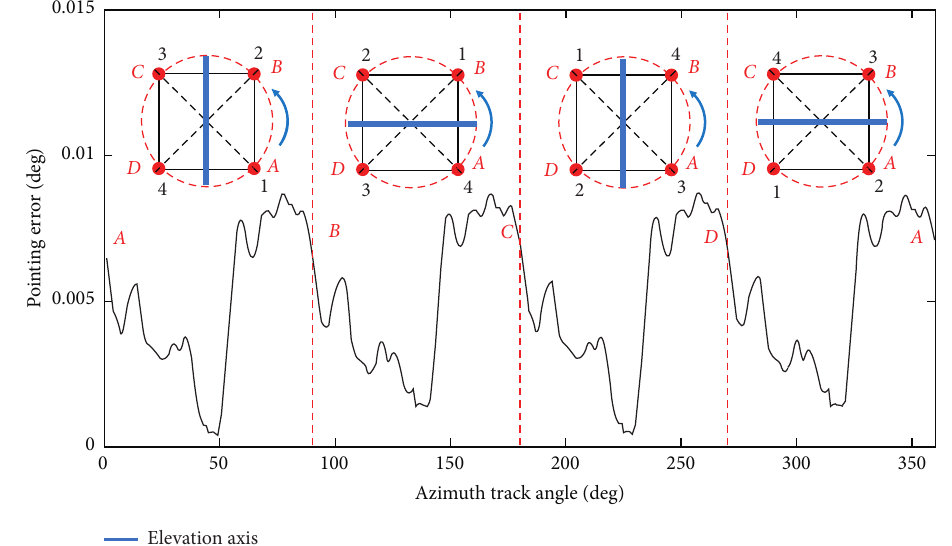
Figure 9: Telescope pointing error for a four-support-point case (Elevation angle is set to be 1